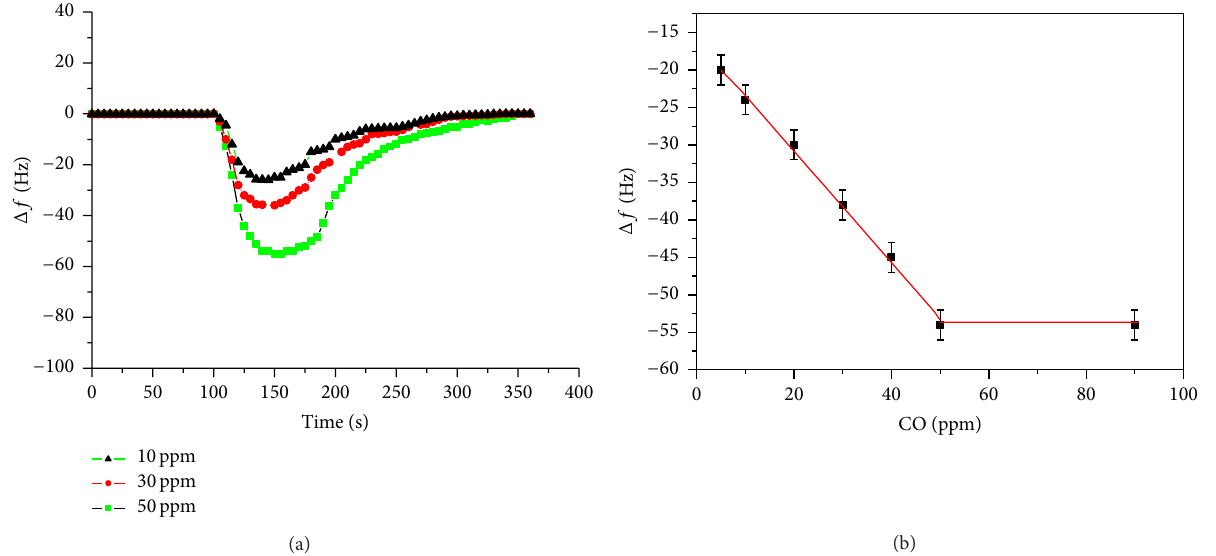
Figure 6: (a) The response characteristics of PEDOT:PSS/PVP nanofiber membrane sensing to 10, 30, and 50 ppm CO. (b) Relationship of frequency difference with CO